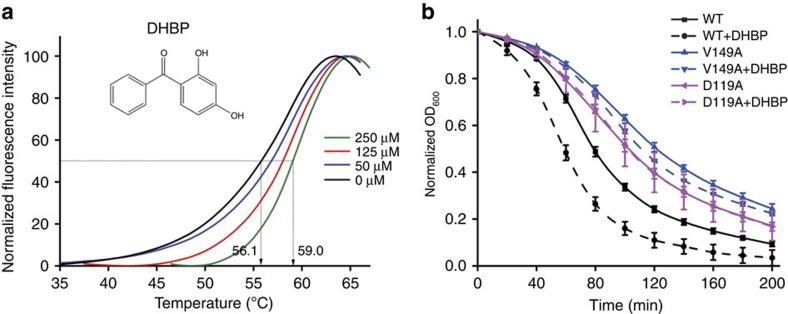
DHBP is capable of activating WalKR TCS via targeting erWalK.(a) Thermal shift assay indicates the direct binding of DHBP to erWalK. (b) DHBP selectively promotes the lysostaphin-induced lysis activity of the Newman wild-type strain, but not the D119A mutant. Cells were grown to OD600 of ∼1.4 with the supplementation of 75 μM DHBP (as indicated) before harvesting for analysis. The decline of OD600 was utilized to measure lysis activity. The experiments were performed in triplicate. The error bars represent the s.d. of the analysed data.